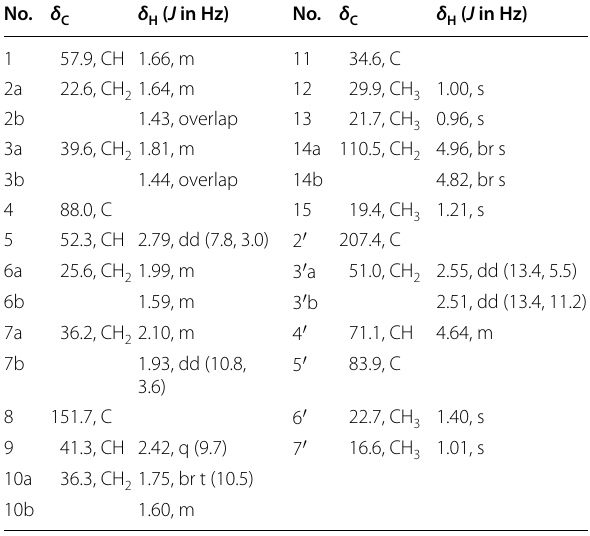
Table 1 13 C (150 MHz) and 1 H (600 MHz) NMR spectroscopic data of compound 1 in CDCl